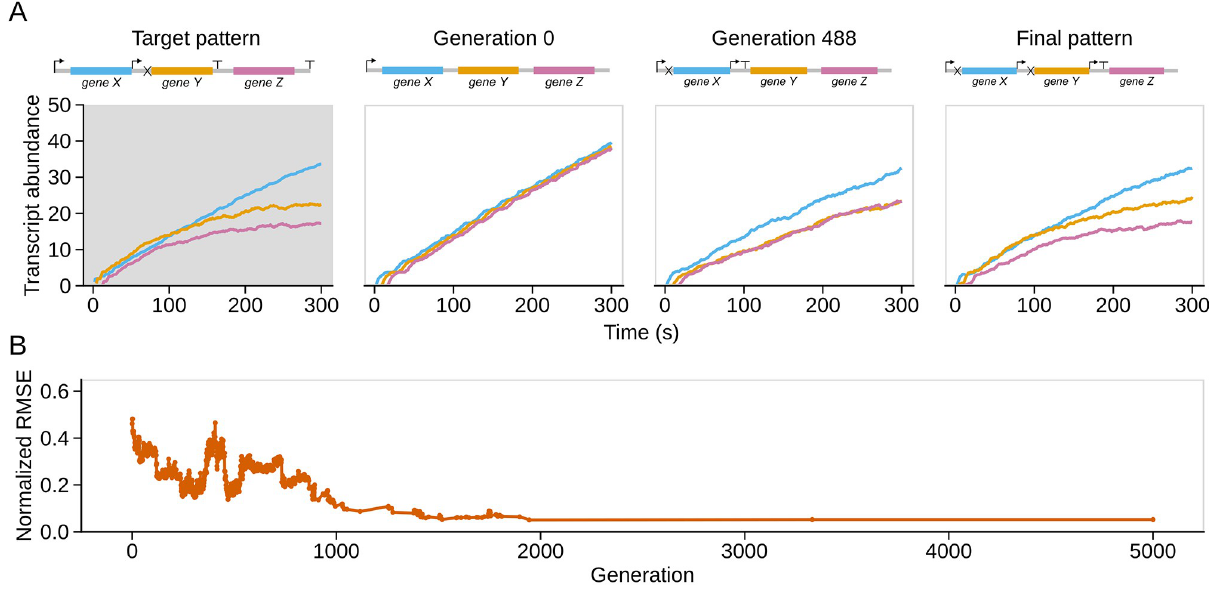
Fig 1. Evolutionary simulation of a positive control gene expression pattern. A: Genome architectures and corresponding gene expression time courses. The target pattern (first panel) is a gene expression time course generated by an arbitrarily chosen genome architecture simulated in Pinetree. This architecture has a promoter in front of genes X and Y (indicated by inverted L with an arrow pointing right), a transcriptional terminator after genes Y and Z (indicated by a T), and an RNase cleavage site in front of gene Y (indicated by a cross). Line colors correspond to the genes labeled in the genome architecture. We use these symbols and colors consistently throughout this work to display genome architectures. The remaining panels illustrate the evolutionary process: the starting genome architecture and corresponding gene expression time-course (generation 0), an example from the middle of the evolutionary simulation (generation 488), and the final evolved architecture (final pattern). The final evolved genome architecture is similar but not identical to the target. B: The normalized-RMSE metric declines with increasing numbers of generations as the genome architecture evolves to reproduce expression patterns that are increasingly similar to the target